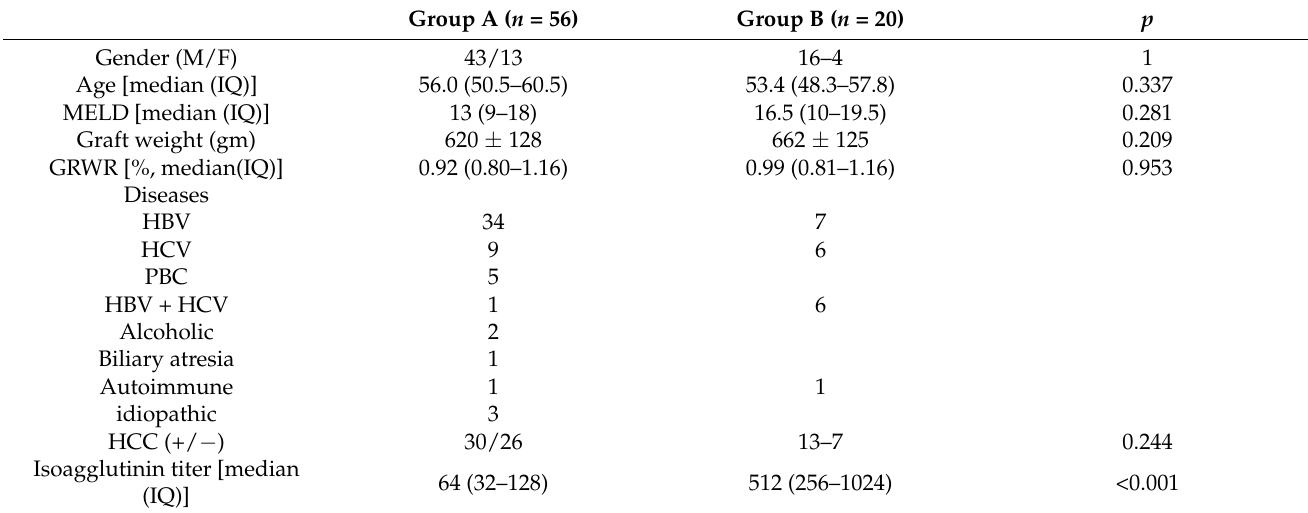
Table 1. Clinical characteristics of group A and B